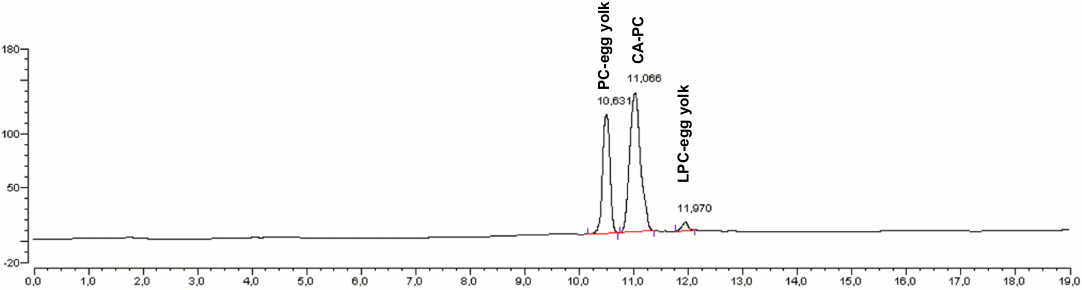
Figure 6. HPLC chromatogram of fraction of modified phospholipid.